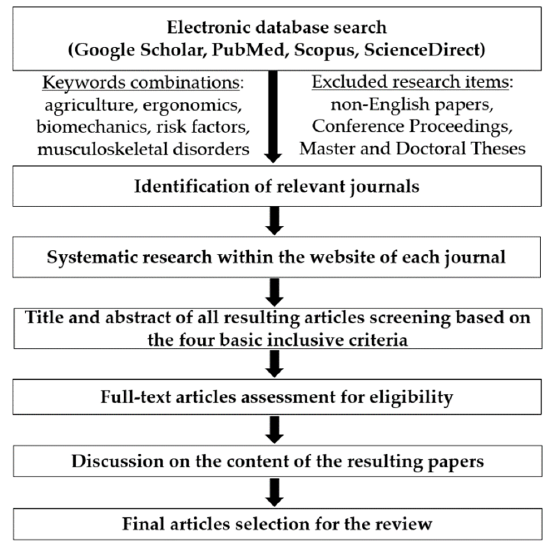
Figure 1. Flowchart of the present review methodology.